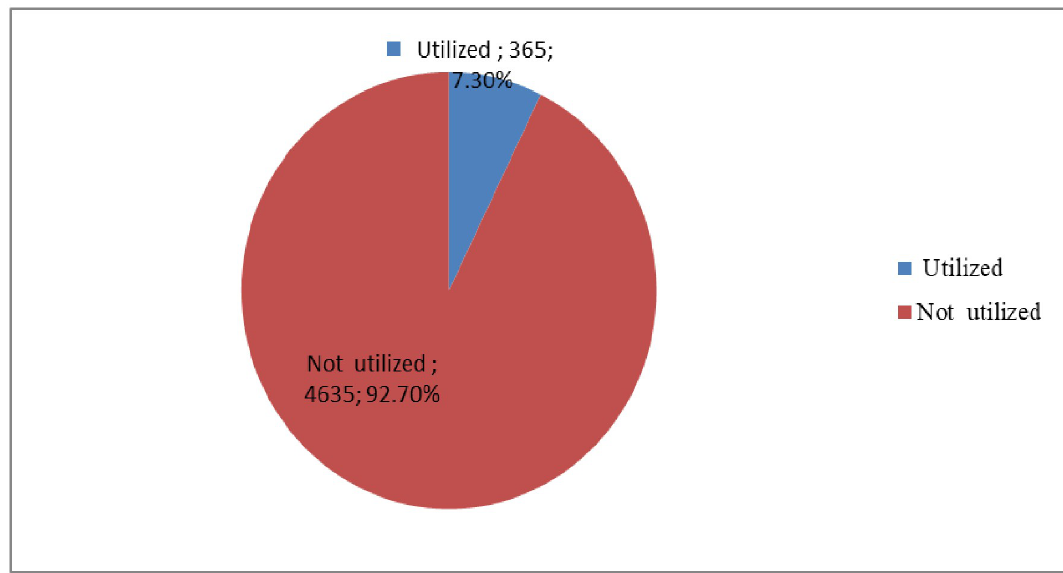
Fig 2. Utilization status of deworming medication among pregnant mothers with at least one ANC visit in Ethiopia, 2022.